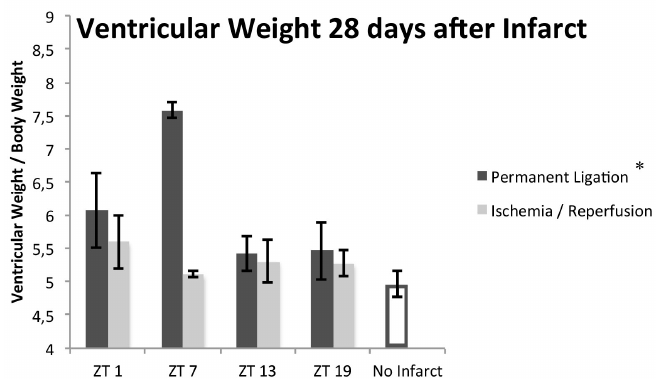
Figure 2. Ventricular weight 28 days after the infarct. Compared to sham controls, PL mice had an increase in biventricular mass that showed a significant 24-h rhythm peaking at ZT7 (the middle of the inactive/resting period). In IR mice, no significant increase or 24-h rhythm was present. n = 20, 18, and 14 for PL, IR, and sham respectively; n = 3–5 per timepoint. Striped line indicates control value; * Indicates p < 0.05 for the presence of 24-h rhythm. ZT: Zeitgeber Time (ZT0 = lights on).